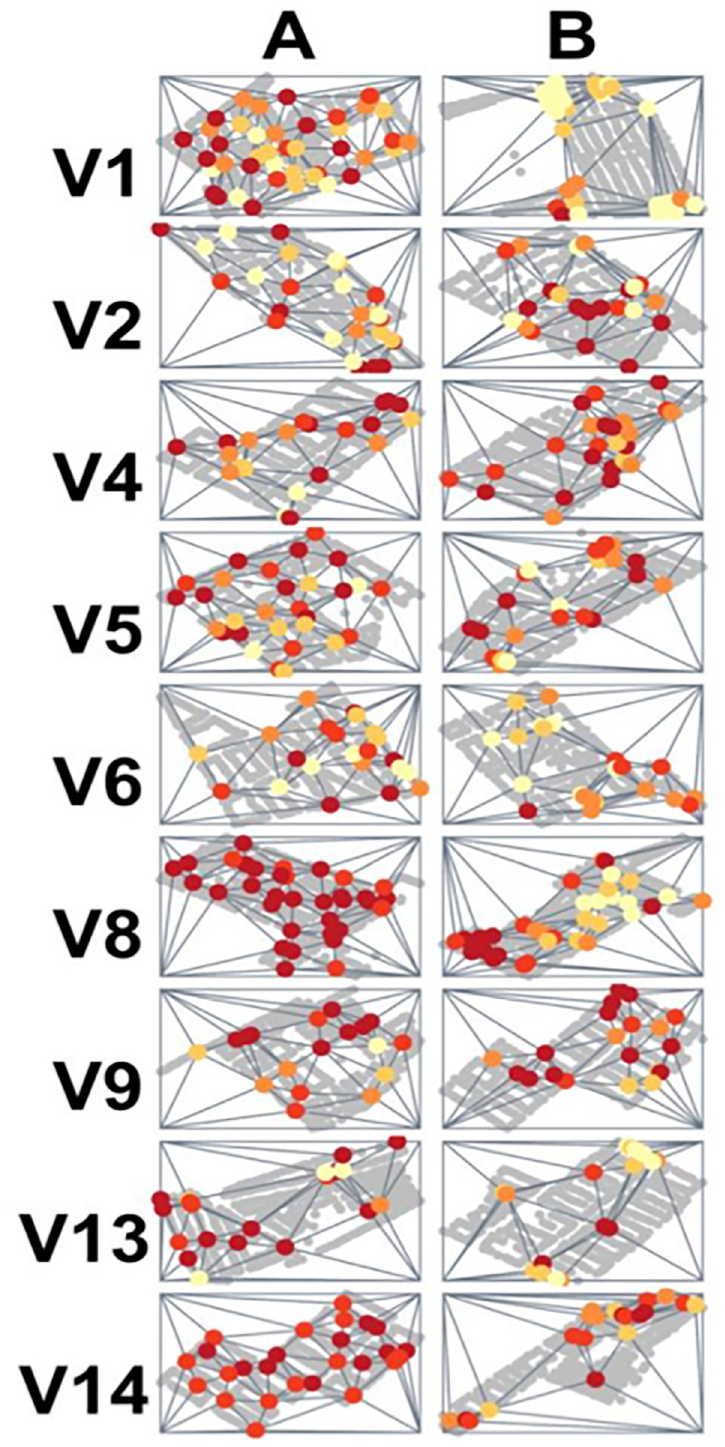
Fig 9. Spatial coverage maps for each participant in the Miraflores trial. Rows represent nine participants; columns represent trial arms. Incentives used in each arm were: A) poker incentive; and B) pay per detection. Spatial coverage is represented by Delaunay triangulation in which triangles are formed connecting inspected houses (colored dots represent the inspected houses by the infestation risk shown as a gradient from yellow (lowest quintile) to dark red (highest quintile). Arm A had significantly higher spatial coverage than Arm B (paired t-test, p < 0.05).